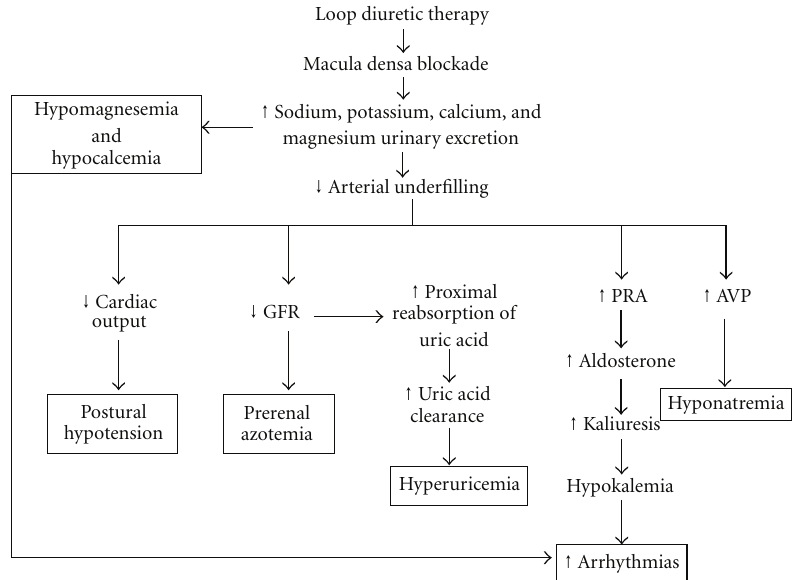
Figure 4: The mechanisms of adverse e ff ects of loop diuretics (with permission from